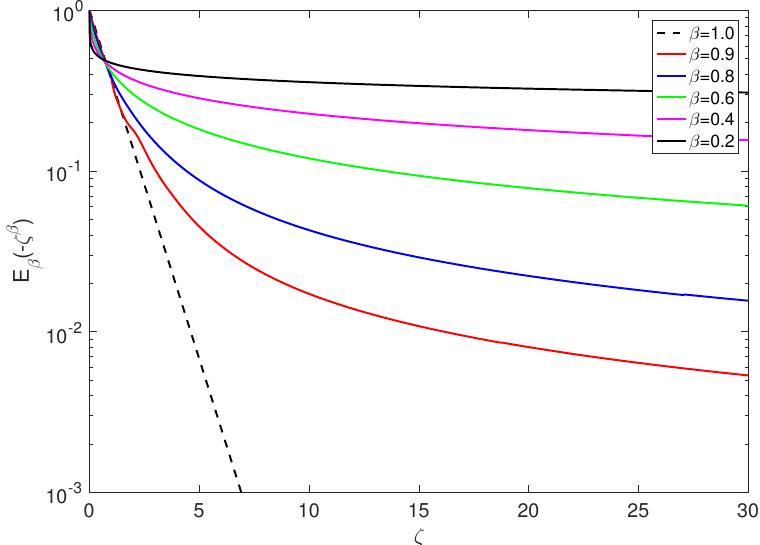
Figure 2. Plots of Mittag-Leffler function E β ( − ζ β ) for various β values. Log–linear